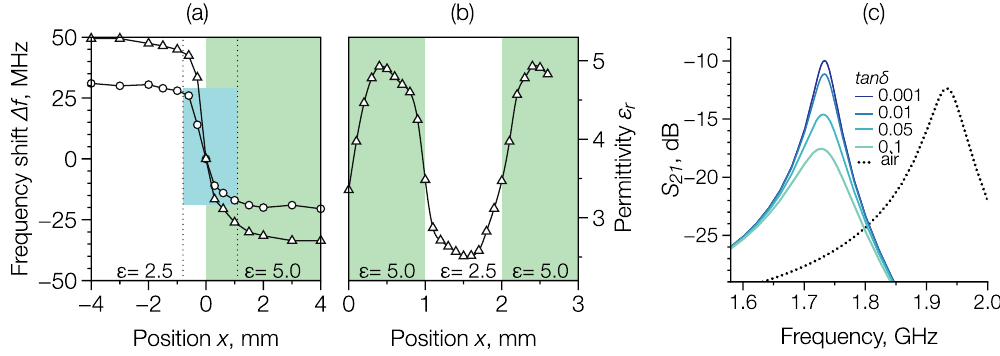
Figure 6. Simulated resonant frequency shift Δ f 0 in a material composed of alternating strips with ε 1 = 2.5 and ε 2 = 5.0, for SRR probes with w = 5 mm, h = 0.8 mm, g = 0.35 mm, and radius r = 7 mm (triangles) and r = 10 mm (circles) where the width is ( a ) 4 mm and ( b ) 1 mm; ( c ) simulated transmission parameters S 21 near the resonance frequency of the SRR probe in contact with a material with ε r = 2.5 and tan δ in the range 0.1 to